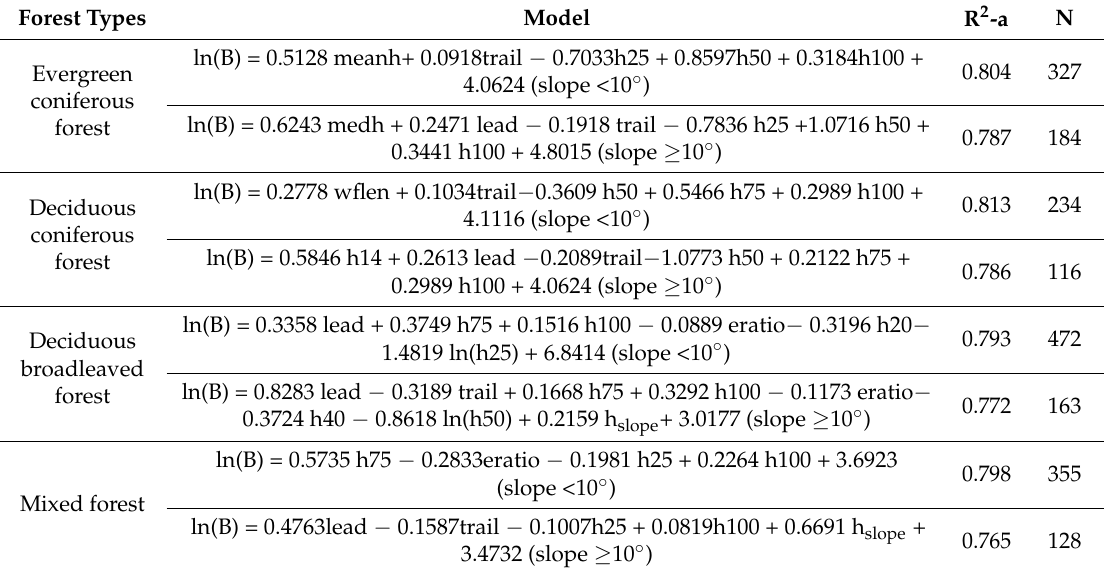
Table 7. Stratified regression models of AGB estimated from GLAS waveform data. Adjusted R 2 were the Goodness of Fit for four forest types (B = AGB, N = number of GLAS footprints sampled by forest plots used in each